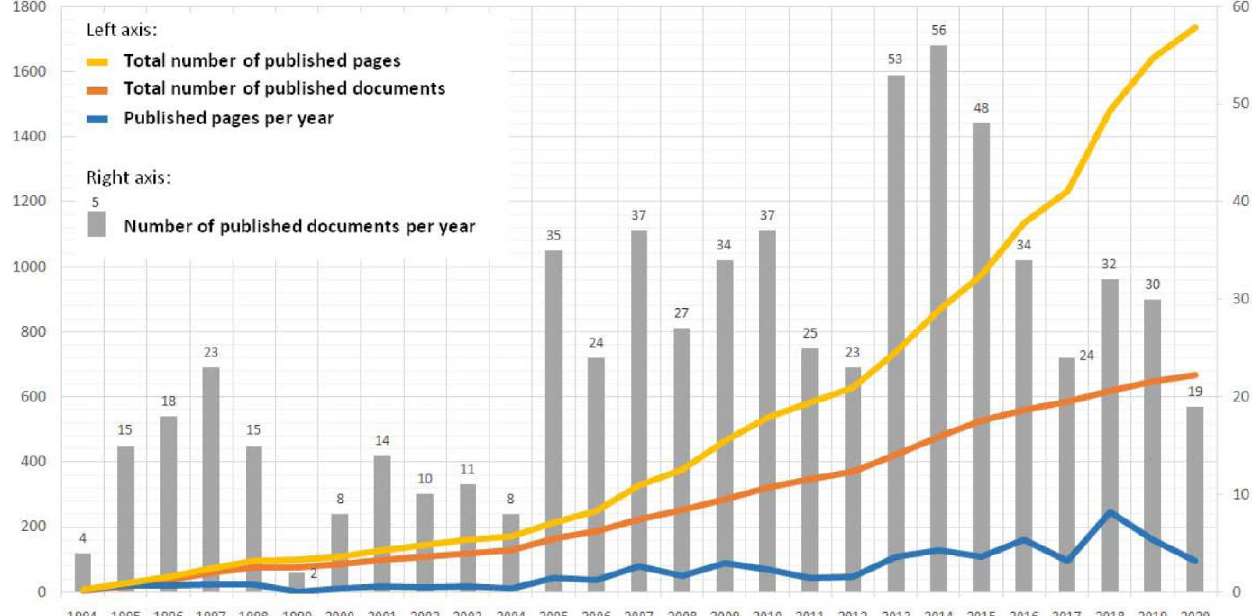
Figure 3. Annual publication activities in the context of the Hydrocarbons Directive.